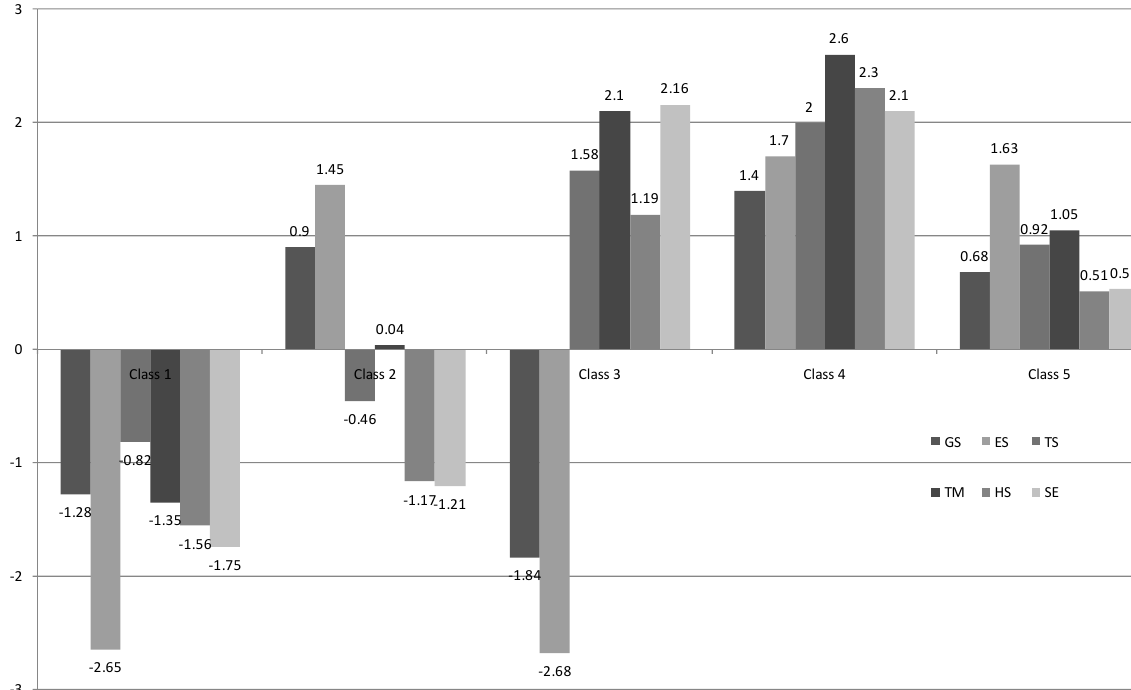
Figure 2. Study 2 standardized subscale means by